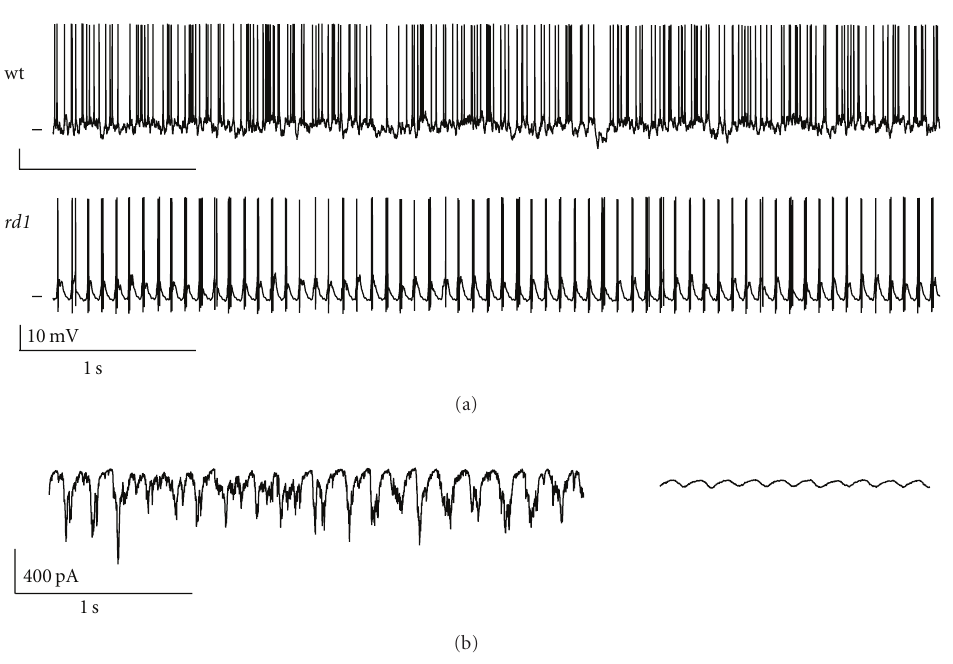
Figure 1: Spontaneous activity in rd1 alpha ganglion cell. (a) Whole-cell current clamp recordings of ongoing spiking activity in wild-type (top) and rd1 (bottom) ON-type retinal ganglion cells. Horizontal tick mark at left indicates − 60 mV for wt and − 70 mV for rd1 cells, respectively. (b) Whole-cell voltage clamp recording of ongoing synaptic currents in an rd1 ON ganglion cell before (left) and after (right) bath application of CNQX.